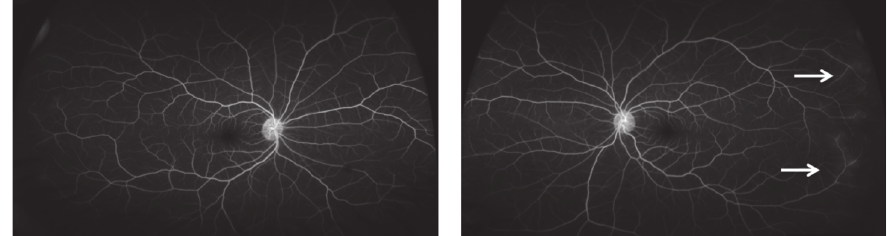
Figure 2: Ultra-wide-field fluorescein angiography of a patient with microscopic polyangiitis showing mild peripheral late leakage in the left eye (arrows) outside the range of standard field